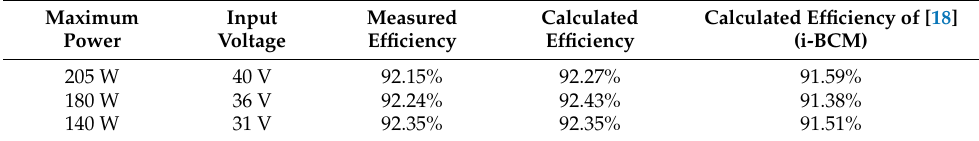
Table 3. European Weighted Efficiency.